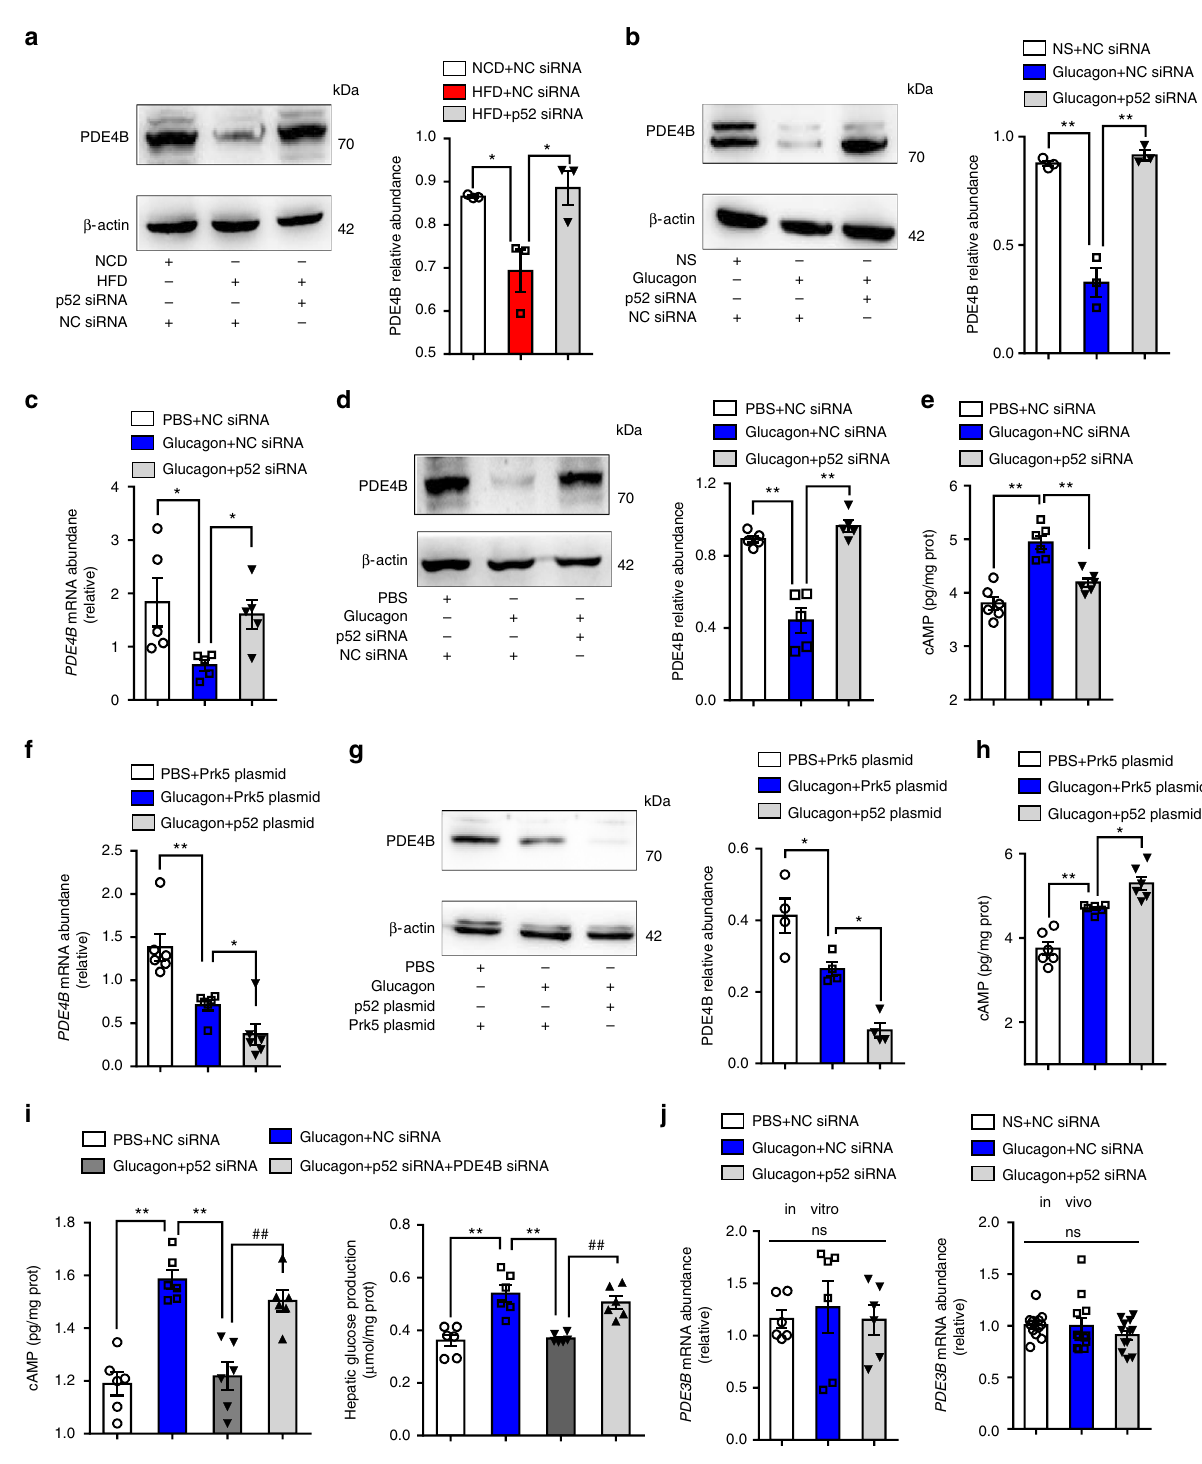
Fig. 3 p52 inhibits PDE4B expression to promote cAMP accumulation. a , b Liver PDE4B protein expression in HFD-fed ( a ) and glucagon-stimulated mice ( b ). Bar graphs represent data normalized to β -actin levels ( n = 3). c The mRNA levels of PDE4B in HepG2 cells transfected with p52 or NC siRNA ( n = 5). Bar graphs represent the levels of genes normalized to β -actin . d The protein expression of PDE4B in p52 knocked down HepG2 cells, β -actin levels served as loading control ( n = 5). e cAMP level in HepG2 cells transfected with p52 siRNA ( n = 6). f The mRNA levels of PDE4B in HepG2 cells transfected with p52 overexpression plasmid ( n = 5). g Western blotting of PDE4B in p52 overexpression cells ( n = 4). h cAMP level in HepG2 cells transfected with p52 overexpression plasmid ( n = 6). Bars represent mean±SEM values. i Intracellular cAMP levels and glucose output in primary hepatocytes transfected with p52 siRNA with or without PDE4B siRNA ( n = 6). j Relative mRNA abundance of PDE3B in glucagon stimulated HepG2 cells (100nM glucagon for 1h, in vitro) or mice liver tissue (2mg/kg glucagon for 1h, in vivo), β -actin levels used as a reference ( n = 6). PDE phosphodiesterase, HFD high-fat diet, NS normal saline,